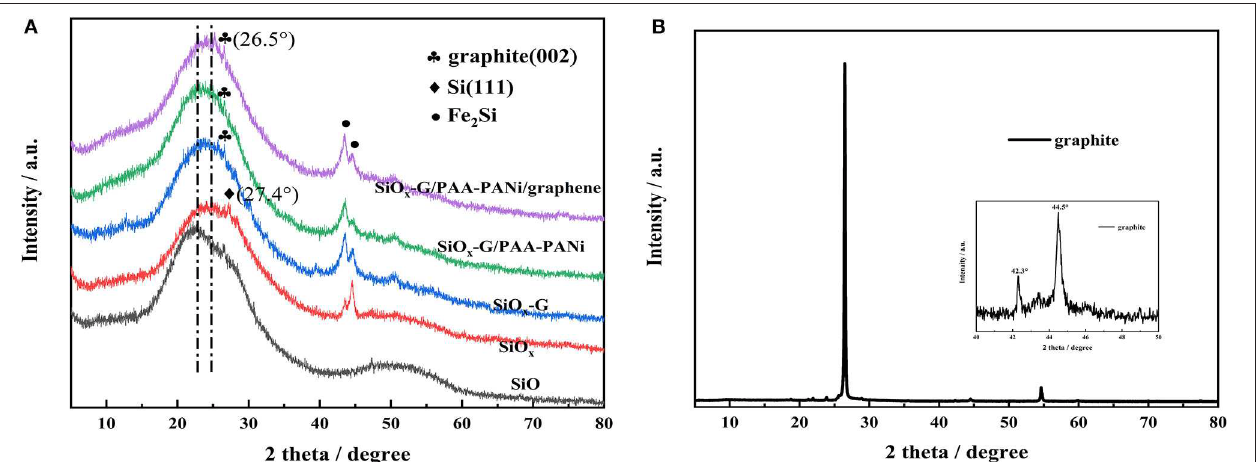
FIGURE 1 | (A) XRD image of SiO, SiO x , SiO x -G, SiO x -G/PAA-PANi, and SiO x -G/PAA-PANi/graphene; (B) XRD image of graphite.